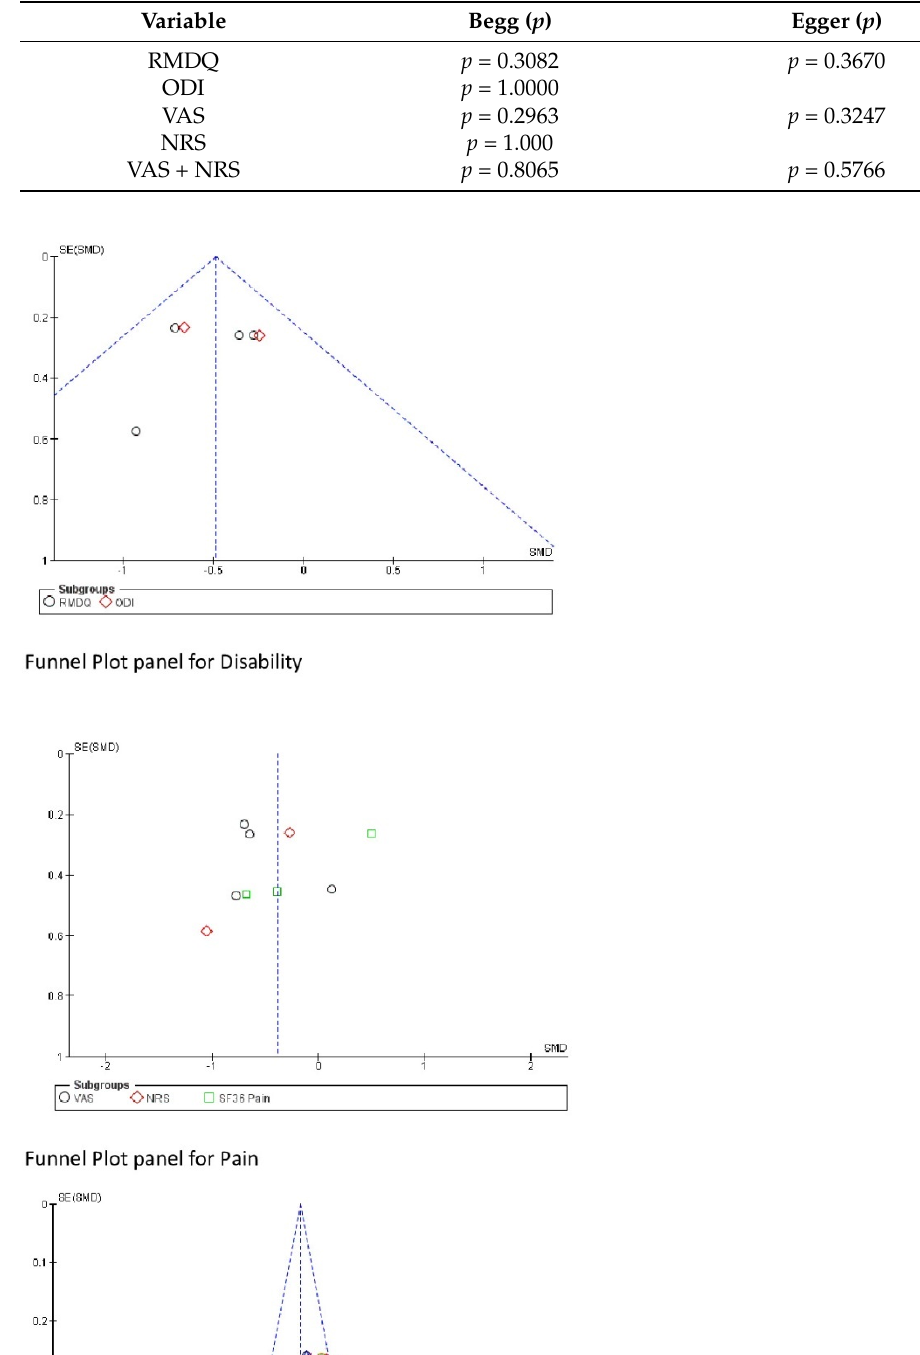
Table 2. Begg and Egger tests.